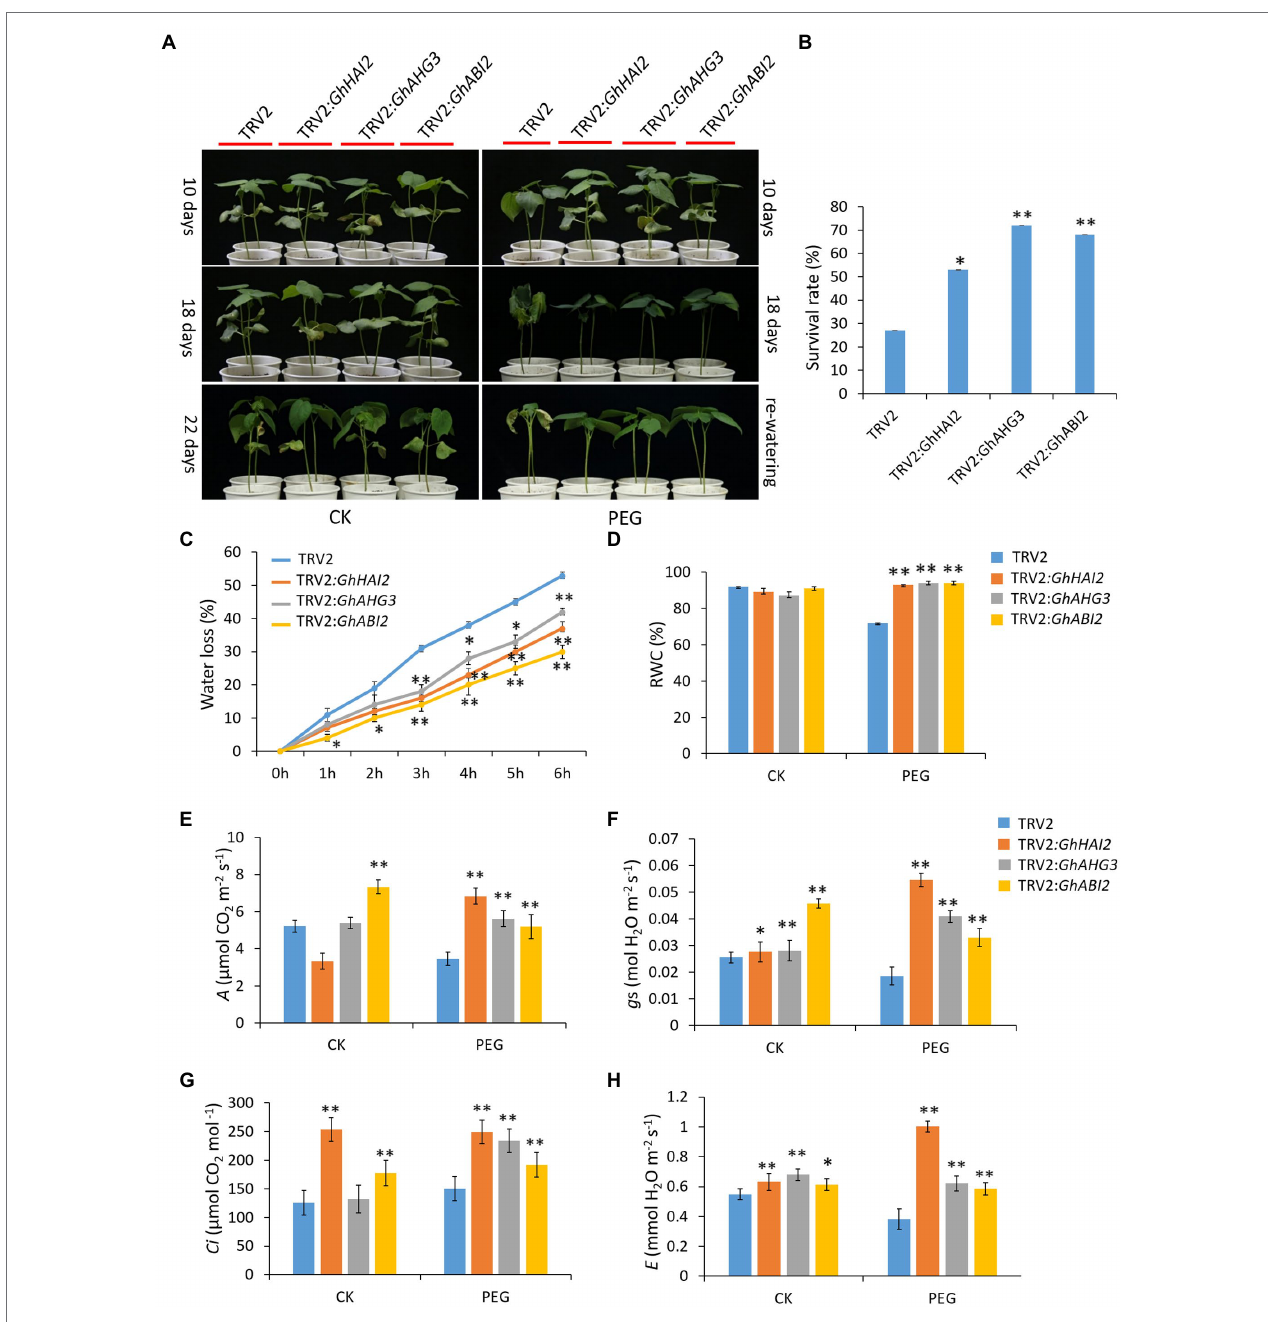
FIGURE 3 | GhHAI2 , GhAHG3, and GhABI2 genes negatively regulate cotton osmotic response. (A) Phenotypic observations on the GhHAI2- , GhAHG3-, and GhABI2 -silenced and control plants under normal (left panel) and PEG conditions (right panel). Three-week old plants were subjected to PEG treatment for 18 days and re-watered for 2 days. (B) Percentage of surviving plants after re-watering for 2 days. (C) Water loss from TRV2: GhHAI2 , TRV2: GhAHG3, and TRV2: GhABI2 and TRV2:00 seedlings under PEG conditions. (D) Relative water content (RWC) in the leaves of TRV2: GhHAI2 , TRV2: GhAHG3, and TRV2: GhABI2 and TRV2:00 plants under normal and PEG conditions. (E–H) Analyses of gas exchange parameters including, photosynthetic rate ( A ), stomatal conductance ( g s), intracellular CO 2 concentration ( Ci ), and transpiration rate ( E ) in TRV2: GhHAI2 , TRV2: GhAHG3, and TRV2: GhABI2 and TRV2:00 plants under normal and PEG conditions. Bars represent means ± standard deviation of three biological replicates. At least 30 plants were used for each biological replicate. Asterisks represent statistically significant difference between TRV2: GhHAI2 , TRV2: GhAHG3, and TRV2: GhABI2 and TRV2:00 plants (Student’s t -test; * p < 0.05; ** p <